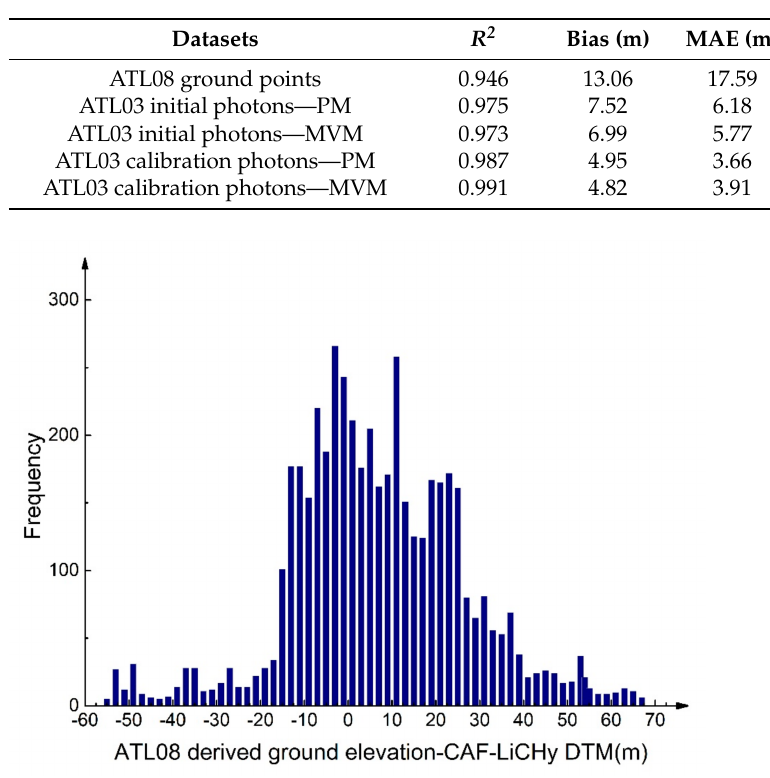
Figure 9. Frequency histogram of the ground elevation errors of ICESat-2data.